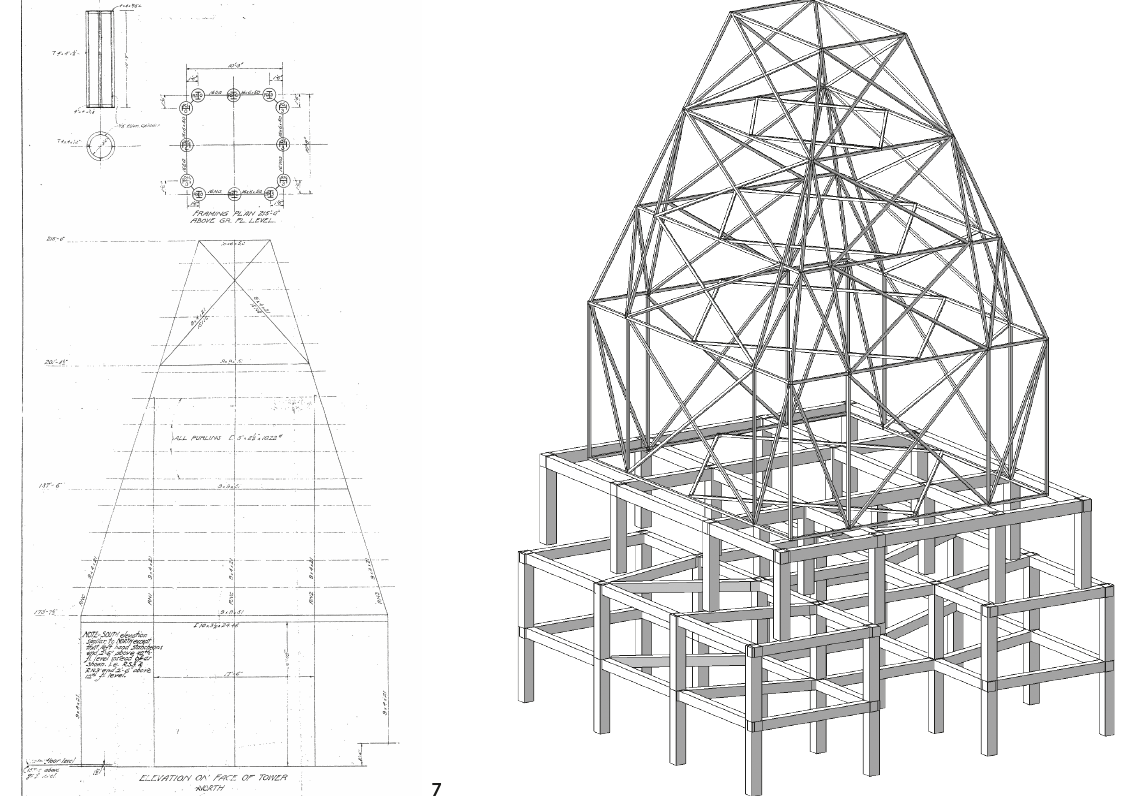
7 Figure 7 Structural Drawing of the Roof of the Sassoon House (Source: Shanghai Urban Construction Archive). Figure 8 The Sassoon House Spire with Complex Spatial Steel Structures (Source: the author).